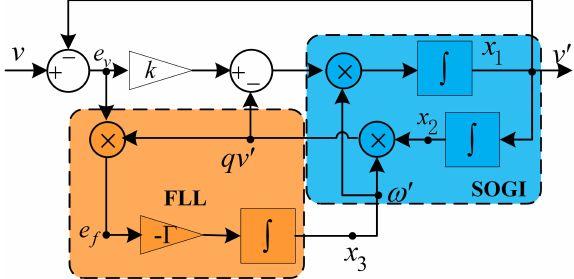
Figure 1. Block diagram of the